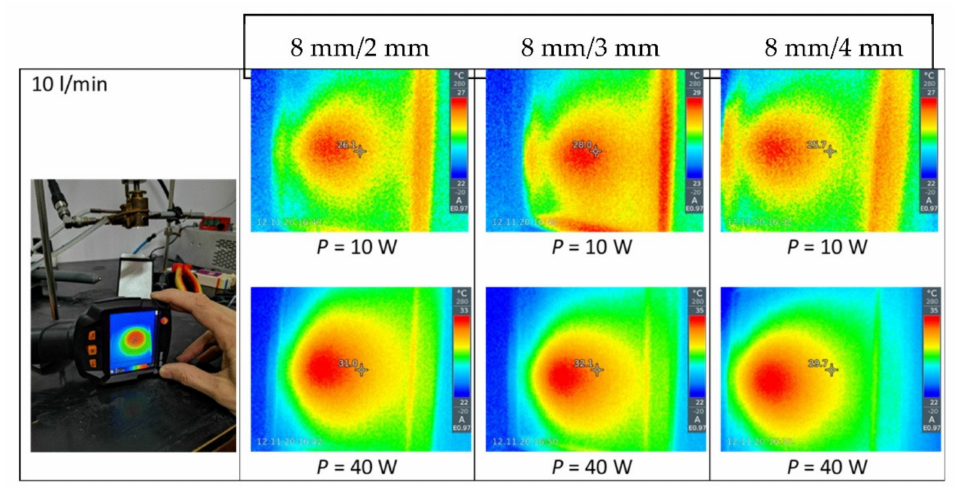
Figure 8. Images from Mica Plate and infrared thermo camera system.